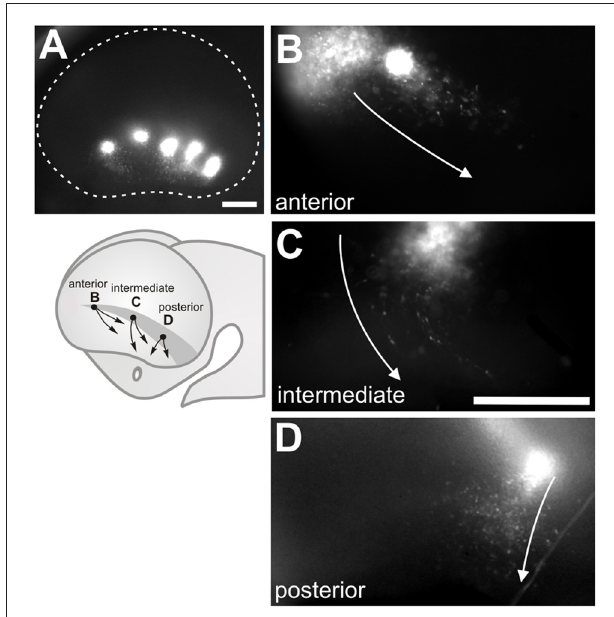
FIGURE 5 | Cells generated at the ventral pallium (VP) migrate ventrally. (A) Multiple CFDA-labeling along the antero-posterior axis of the VP in E11.5 embryos showing a ventral direction of migration. (B–D) Single CFDA labelings (in different embryos) at different positions (arrows depict direction of migration): (B) Anterior VP, (C) Medial VP, (D) Posterior VP. Scale bar: 200 µ